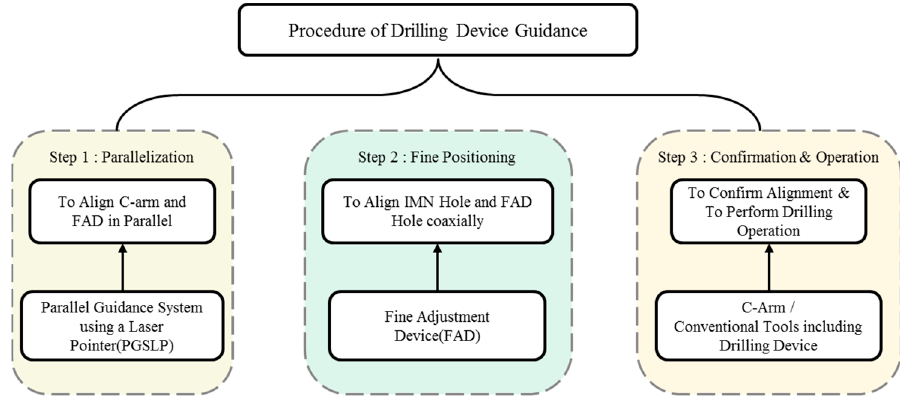
Figure 2. Procedure of drilling device guidance.